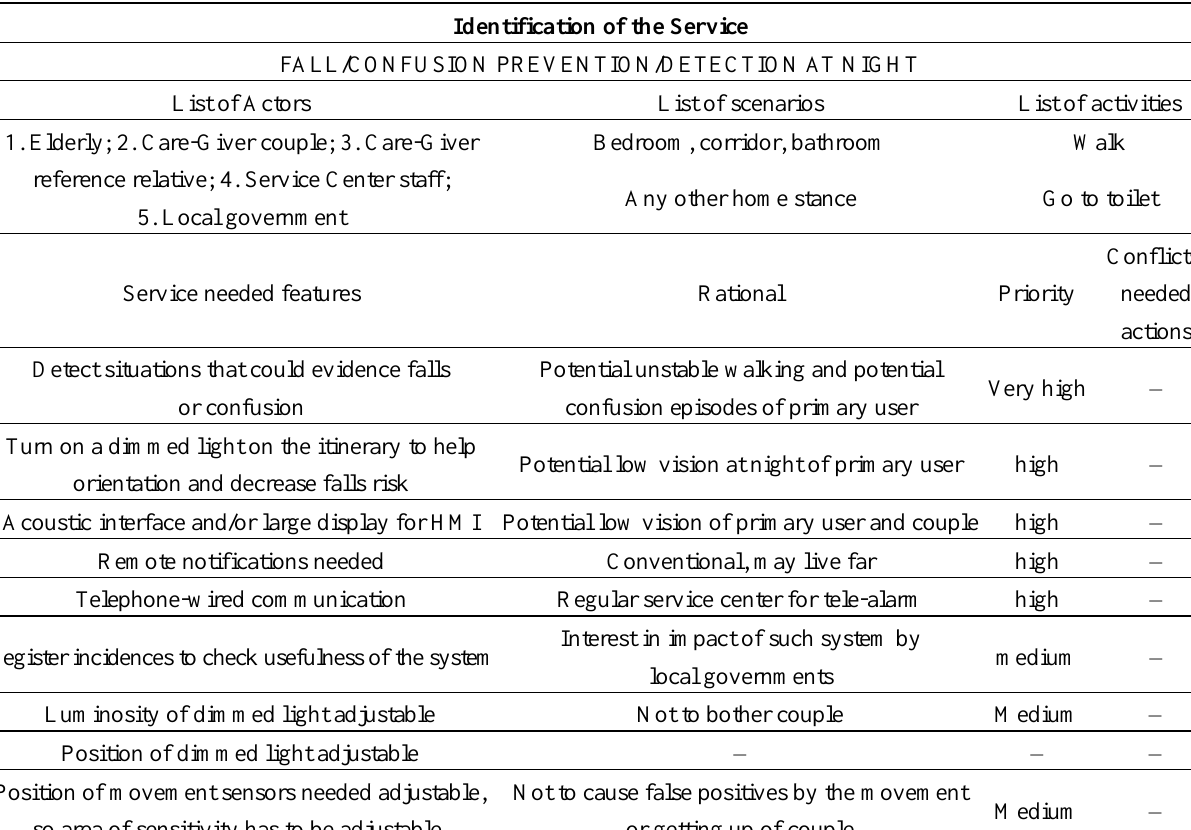
Table 8. Service functional